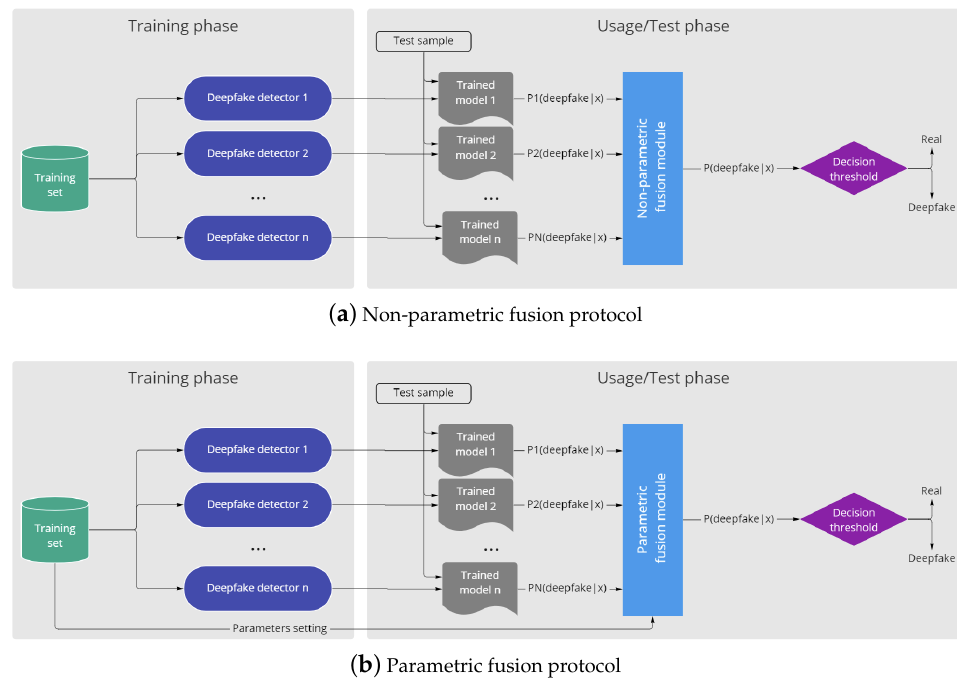
Figure 3. Visual pipelines of non-parametric ( a ) and parametric ( b ) fusion